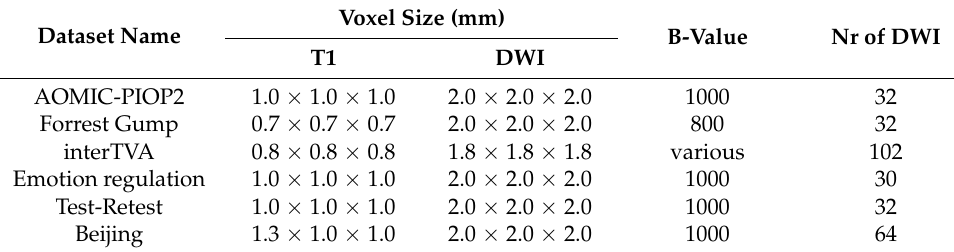
Table 1. Summary of the acquisition parameters of the different